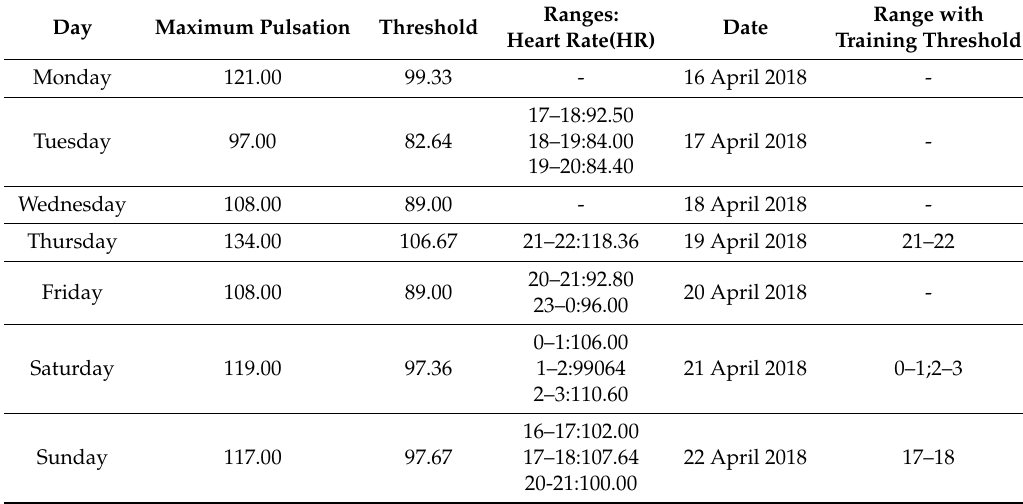
Table 1. Training week 1 from 16 to 22 April.